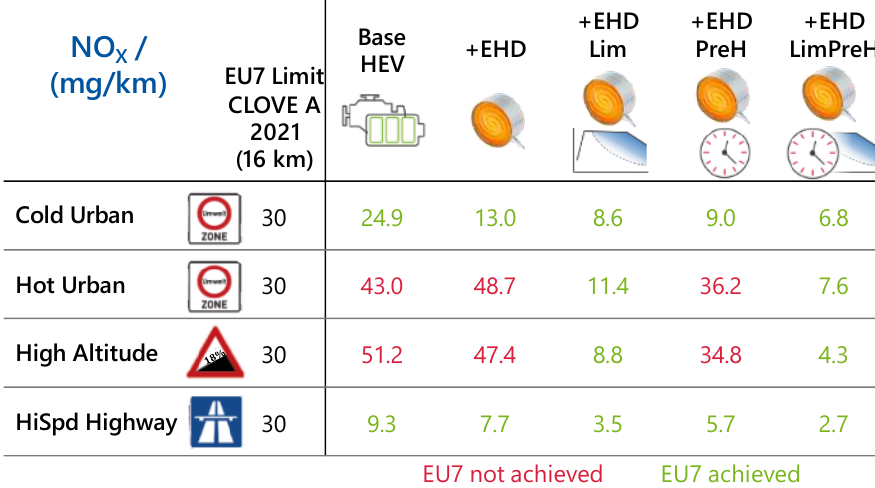
Figure 10. Electrical heater disk results for challenging Euro 7 scenarios.